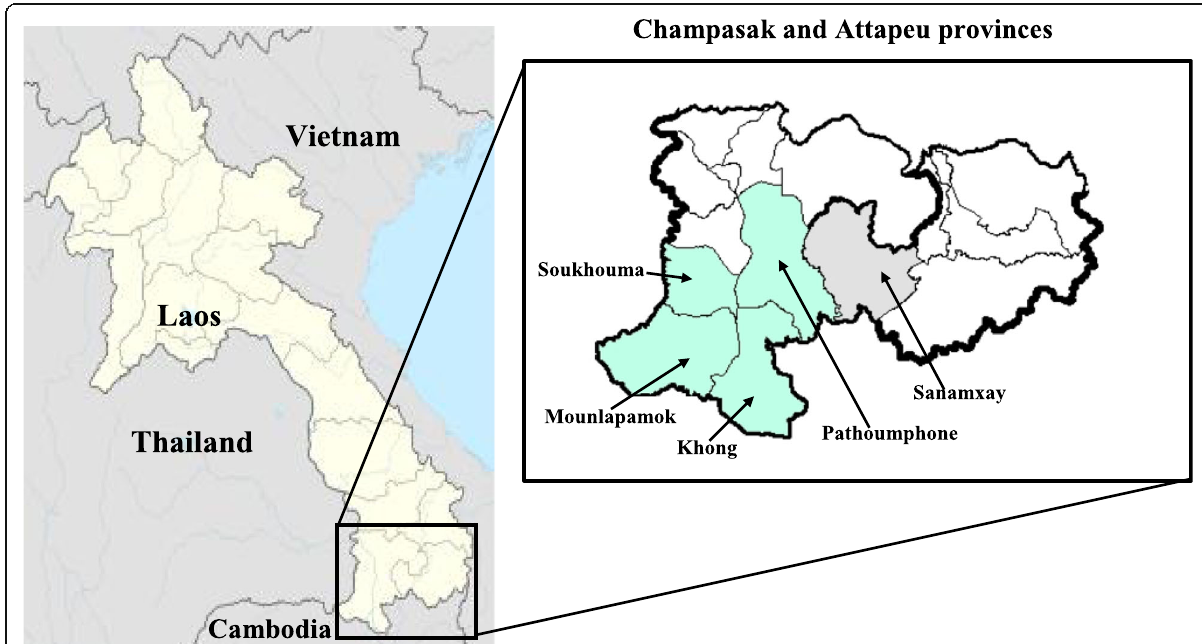
Fig 1 Map of the study sites in Soukhouma, Mounlapamok, Khong, Pathoumphone districts of Champasak province and Sanamxay district of Attapeu, Lao